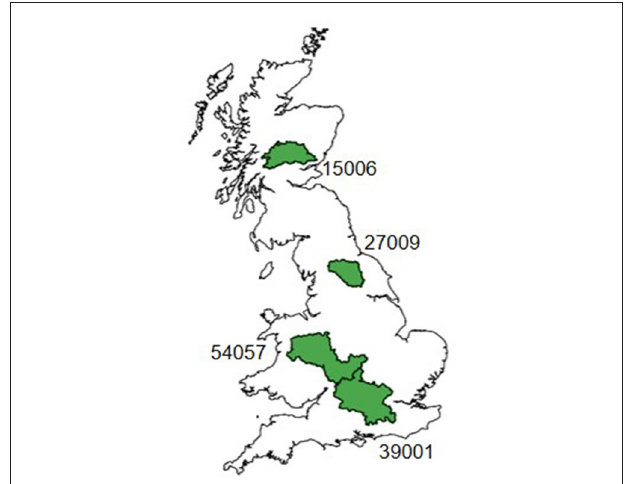
FIGURE 1 | Location of example catchments: the Tay at Ballathie (15006), Ouse at Skelton (27009), Thames at Kingston (39001), and Severn at Haw Bridge (54057). See the Supplementary Material for a summary of catchment